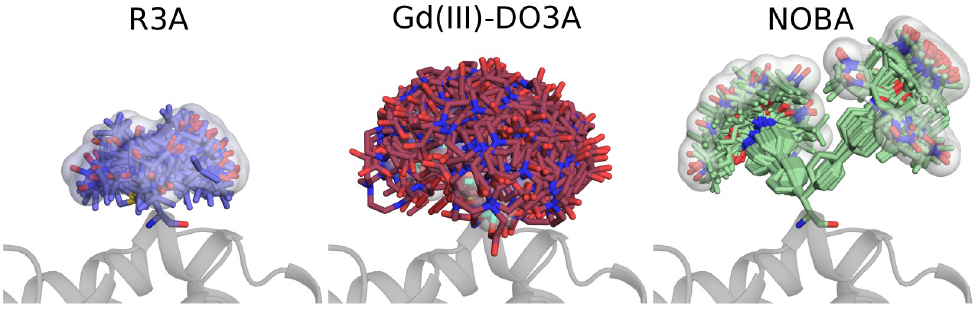
Fig 4. Three spin labels added to chiLife and attached to T4 lysozyme (PDBID: 2LZM) at site 109. R3 (left, sticks with blue carbons) is a small highly mobile nitroxide label. Gd(III)-DO3A (center, sticks with dark red carbons) is a gadolinium- based spin label resistant to reduction. NOBA (right, sticks with green carbons) is a biorthogonal nitroxide. The surface is made by pseudo-atoms at the rotamer spin centers.